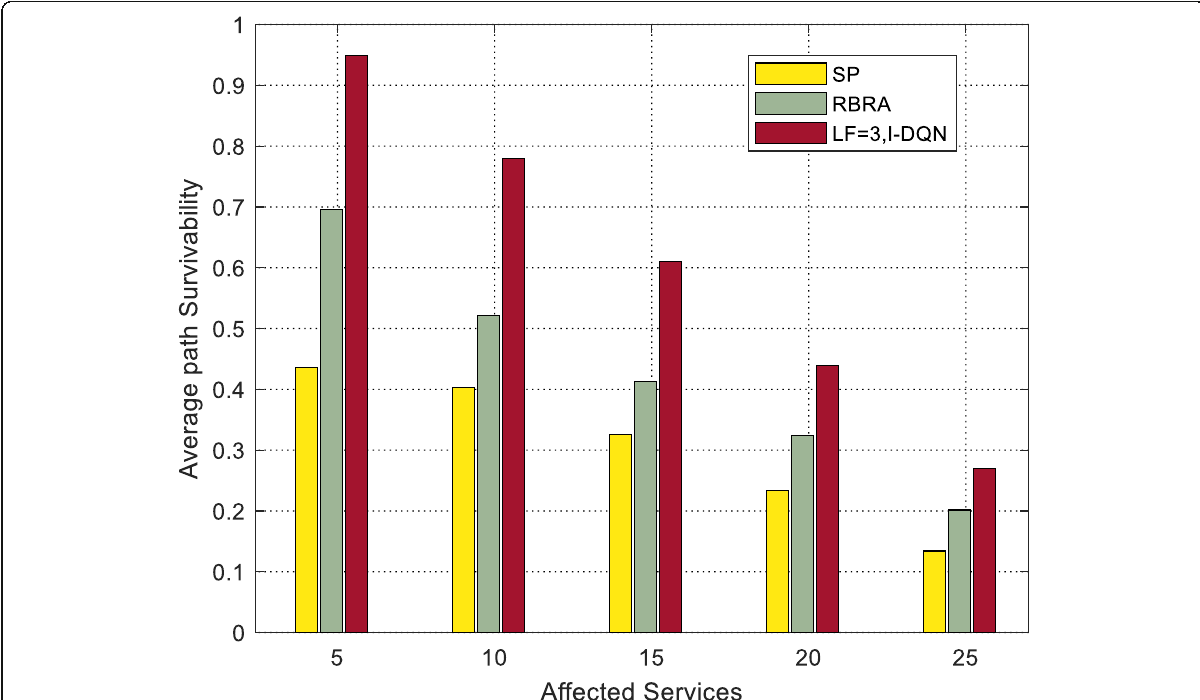
Fig. 11 Average survivability vs. no. of affected services. This figure describes the comparison of average path survivability for different routing strategies, SP, RBRA, I-DQN and LF = 3 vary with different service